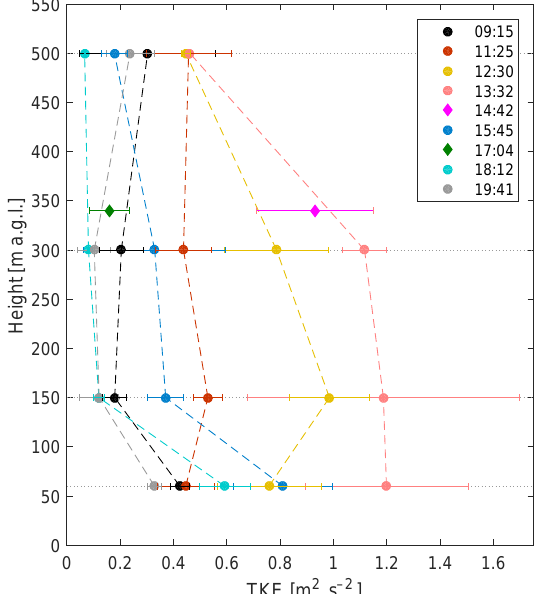
Figure 10. Profiles of TKE from 27 June at Site 2. Consecutive flights are separated by color. The average TKE value over two legs, for each altitude (60, 150, 300 and 500ma.g.l.), is shown by the circles. For the two flights with straight legs at 340ma.g.l., the dia- monds represent the average TKE values. The horizontal bars show the variation between individual legs. The flight times given are all in UTC, and represent the start of each flight.